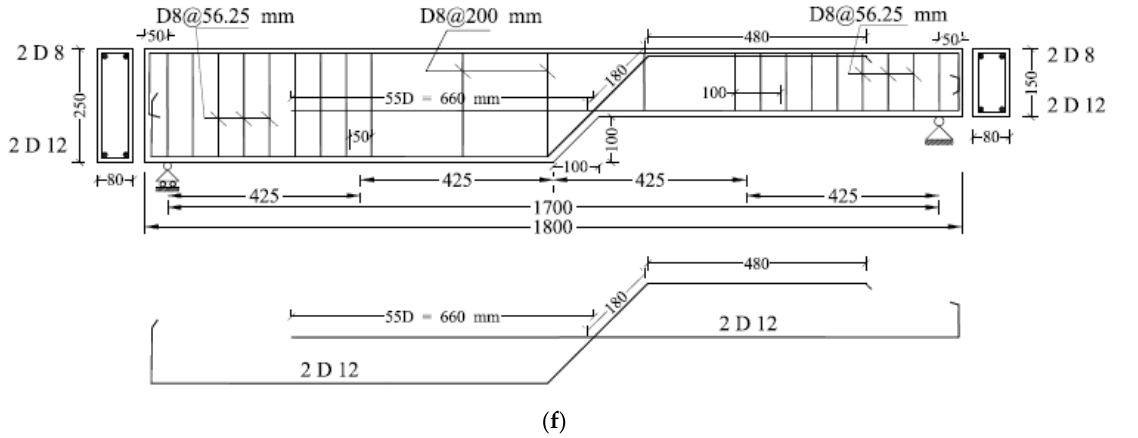
Figure 3. Details of the tested specimens of group G1: ( a ) B1, ( b ) B2, ( c ) B3, ( d ) B4, ( e ) B5, and ( f ) B6.